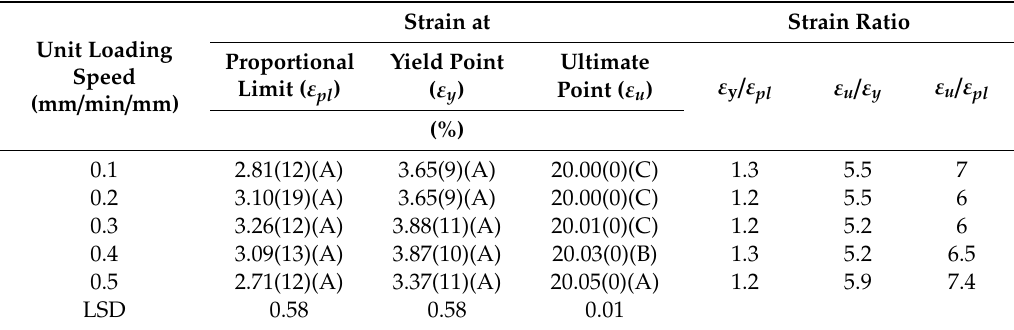
Table 8. Mean values of tensile strains at di ff erent critical points and their mean comparisons for unit loading speed 1